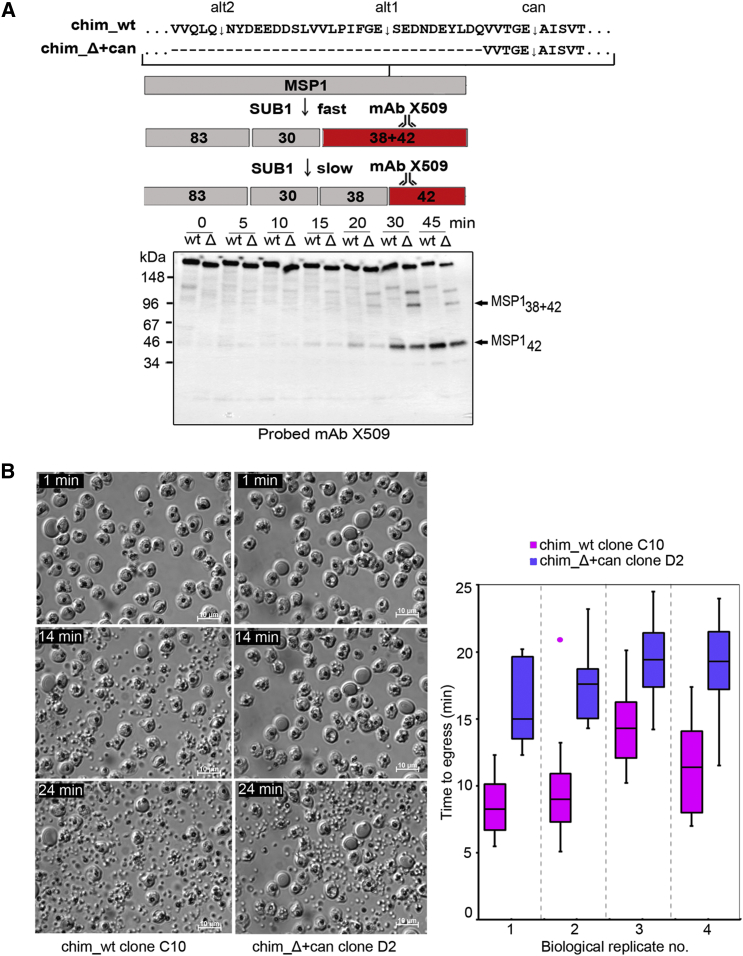
Rate of MSP1 Processing Regulates the Kinetics of Egress(A) Top: the 38/42 region in chim_Δ+can and chim_wt parasites and the MSP1 processing pathway (Child et al., 2010). Bottom: time course comparing processing of MSP1 from chim_Δ+can and chim_wt clones by western blot. Schizonts were sampled at the indicated times following removal of a C1 block. Note the slightly smaller full-length chim_Δ+can MSP1 due to the 69-residue deletion.(B) Left: stills from time-lapse microscopy of chim_Δ+can and chim_wt clones (imaging started 4 min 20 s after C1 removal). Right: box plot comparison of time to egress after C1 removal. Data are from 4 independent experiments each assessing 12–24 egress events per clone. Whiskers, range. A single outlier point (>1.5× the interquartile range) indicated. The chim_Δ+can clones showed a mean egress delay of 7.5 ± 1.4 min (p < 0.005, Student’s t test). Similar results were obtained with two other chim_Δ+can and chim_wt clones (data not shown). See also Figure S5 and Movies S1 and S2.